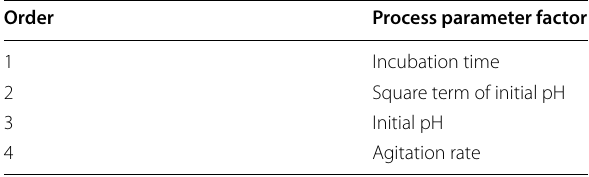
Table 3 Process parameters having significant